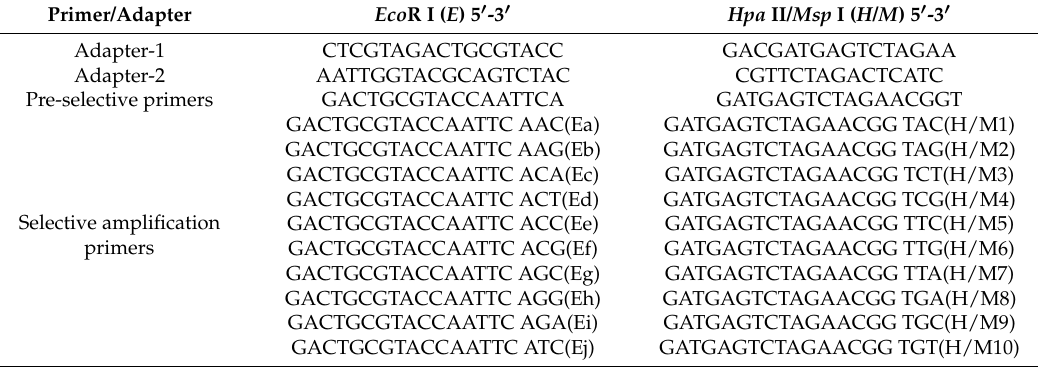
Table 1. Primers and adapters used for methylation-sensitive amplified polymorphism (MSAP).